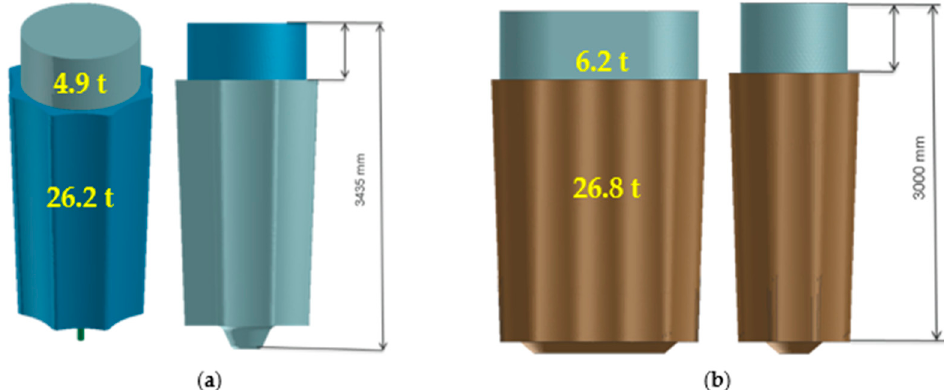
Figure 1. Experimental ingots. ( a ) Conventional polygonal ingot 8K with 4.9 t weighing of the hot top and 26.2 t weighing of the ingot body; ( b ) Newly designed Slab ingot P40N with 6.2 t weighing of the hot top and 26.8 t weighing of the ingot body.